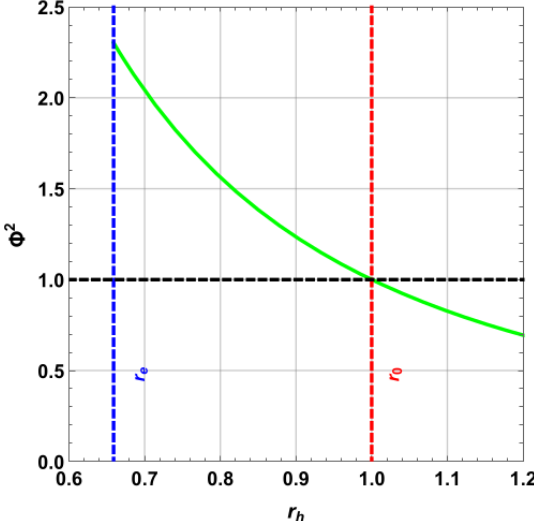
Figure 25. Electric potential square as a function of event horizon radius with Q = 1 , l = 1 , and D = 4